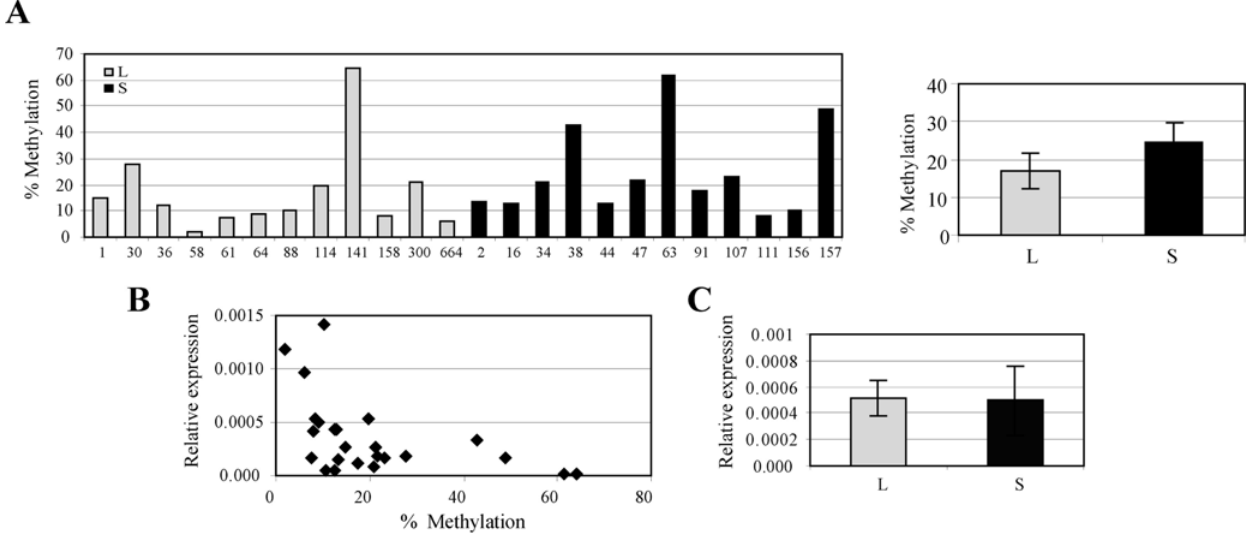
Figure 2. Allele-Specific Expression of RIL in Homozygous EBV-Transformed Cell Lines. (A) Left , Graphic representation of RIL methylation as determined by pyrosequencing with assay A in 12 long (L) and 12 short (S) EBV-transformed cell lines is shown (values represent averages of two independent pyro measurements for each sample). Right , average methylation values + / 2 SEM for homozygous long and homozygous short sample groups are shown. (B) Graphic representation of correlation between relative expression by quantitative PCR (RIL/GAPDH) and methylation for each EBV sample studied is shown. (C) Average expression values + / 2 SEM for unmethylated homozygous long (N=8) and homozygous short (N=5) cell lines with methylation below 15% are shown.